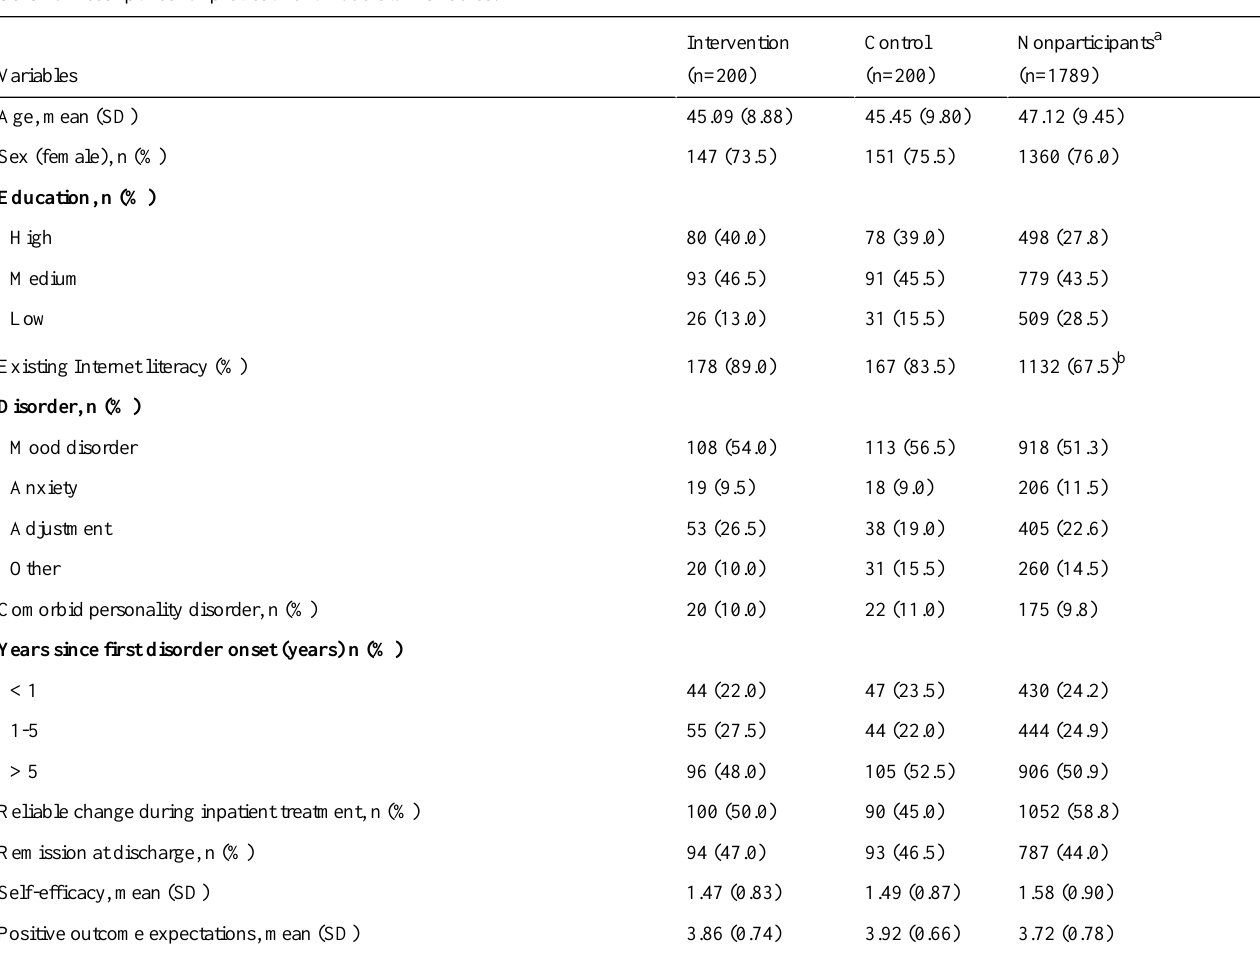
Table 2. Descriptives for pretreatment moderator